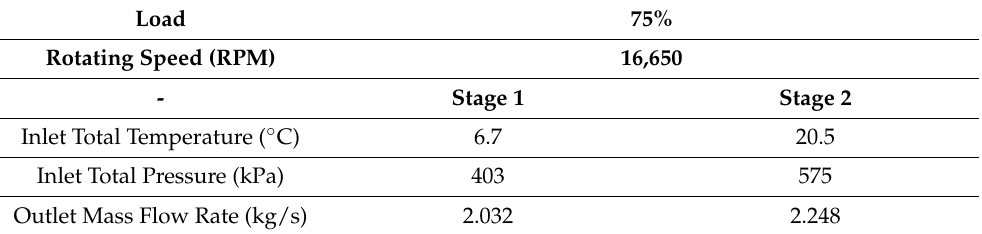
Table 6. Boundary conditions for two-stage IPLV load 75%.